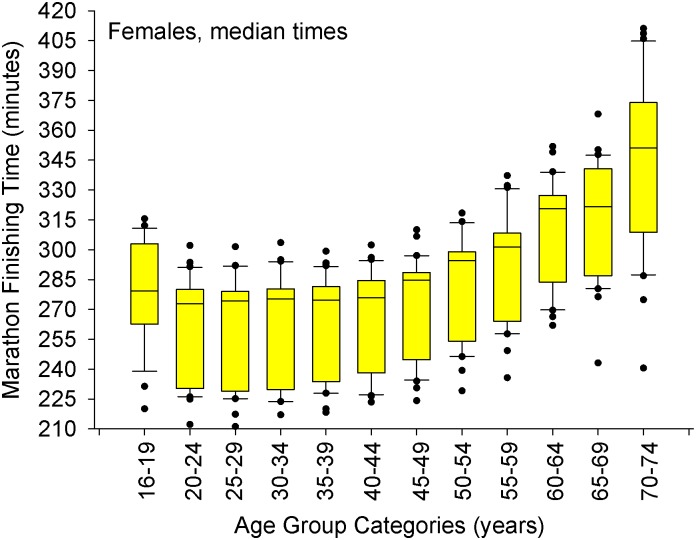
Median marathon finishing times for the females in each age group category.The whiskers (error bars) above and below each box represent the 90th and 10th percentiles, respectively. Each box represents the 25th (bottom border) 50th (middle border), and 75th (top border) percentiles. The solid black circles represent data that are above the 90th percentile or below the 10th percentile, respectively. Using a step-down procedure for multiple comparisons, median times were similar between 24–49 years of age (p = 0.07 for the 2-sided test, adjusted significance, p = 0.14) and then increased in the 50–54 years old age group.